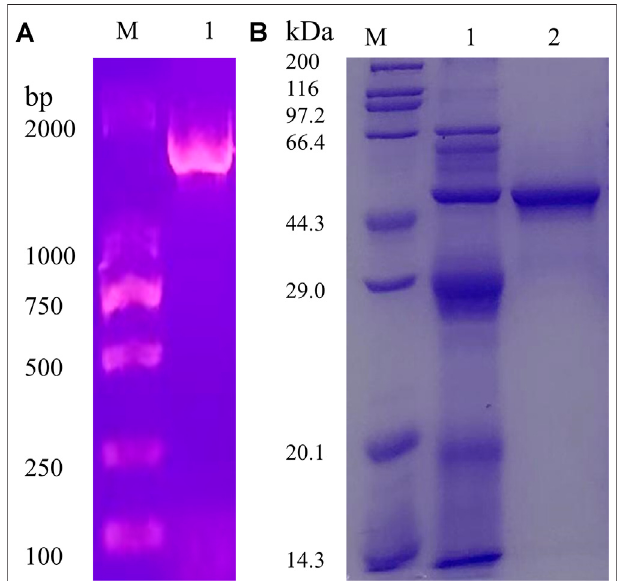
FIGURE 2 | The agarose gel electrophoresis (1%) of the PCR products (A) . The SDS-PAGE (12%) of the proteins during puri fi cation of the recombinant AoNagase expressed in P. pastoris (B) ; Lane 1: The crude enzyme in the supernatant of lysates; Lane 2: The puri fi ed enzyme, eluted by 350 mM – 400 mM NaCl